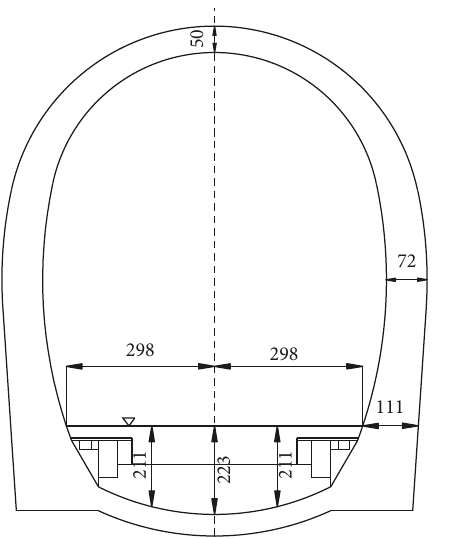
Figure 3: Transverse section of the tunnel lining (unit: cm). Table 2: Material properties of concrete lining and surrounding rocks. Material Physical and mechanical parameters